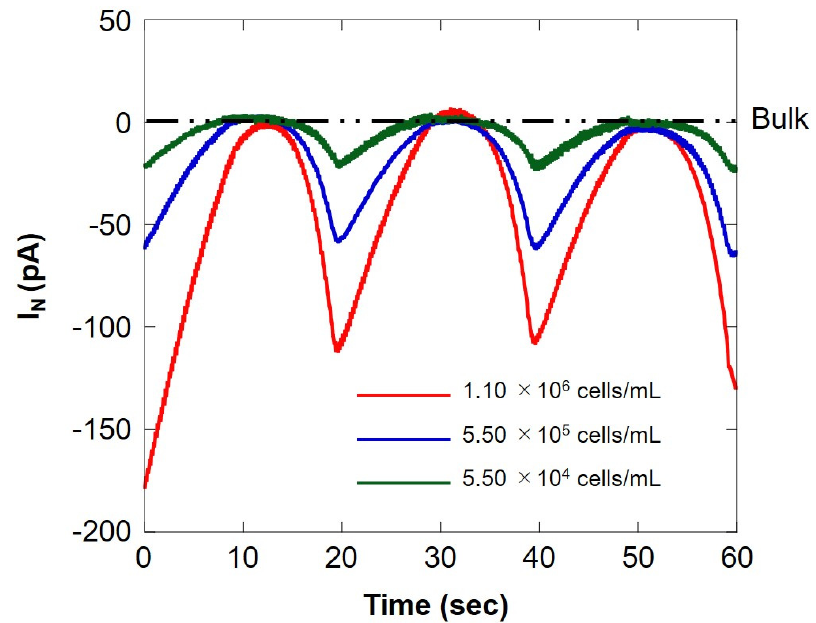
Table 2. SECM ‐ SCC with the milk cell chip. The respiration rate (F) is calculated using Equation (1).